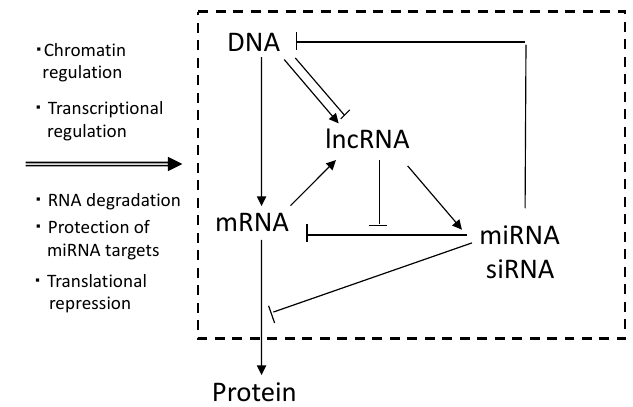
Figure 1. Regulation of ncRNAs in abiotic stress responses. ncRNAs (lncRNAs,